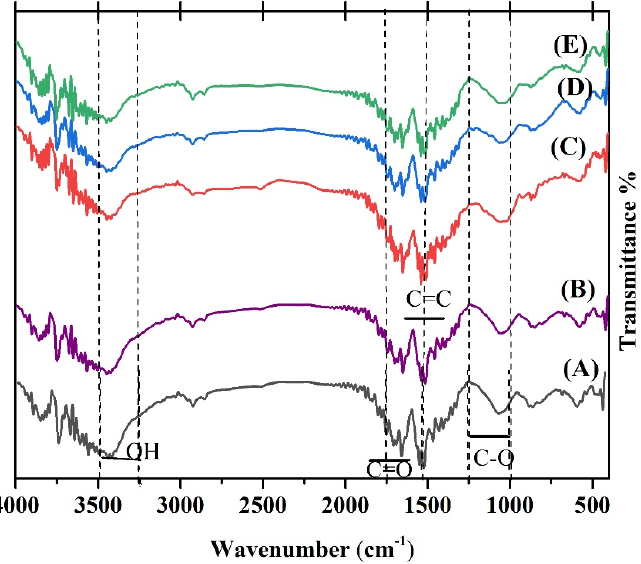
Figure 8. FTIR spectra of 𝜅 -Carrageenan hydrogels ( A ) and κ -Carrageenan hydrogels/Zn 1-x Ag x O. ( B ) x = 0.00, ( C ) x = 0.03, ( D ) x = 0.06, and ( E ) x =